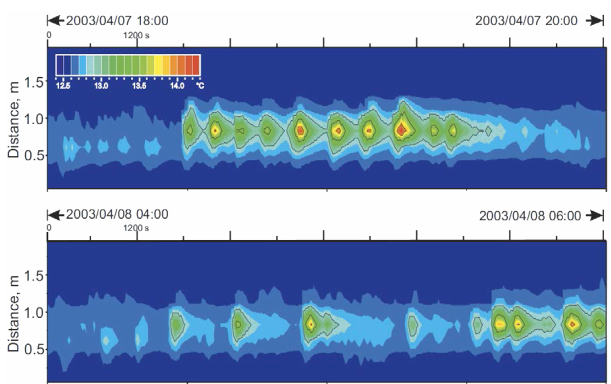
Figure 5. The temperatures in the space–time domain during 2h of the A5a heating experiment when a long train (upper panel) and a likely “doubling of period” (first half of the lower panel) of strong heat pulses are observed. Times of the start and finish are indicated for each panel.